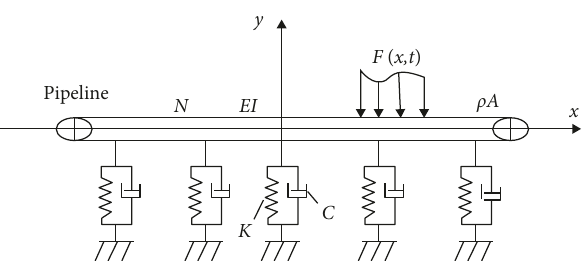
Figure 1: Seismic response calculation model for polymer reha- bilitation pipeline.